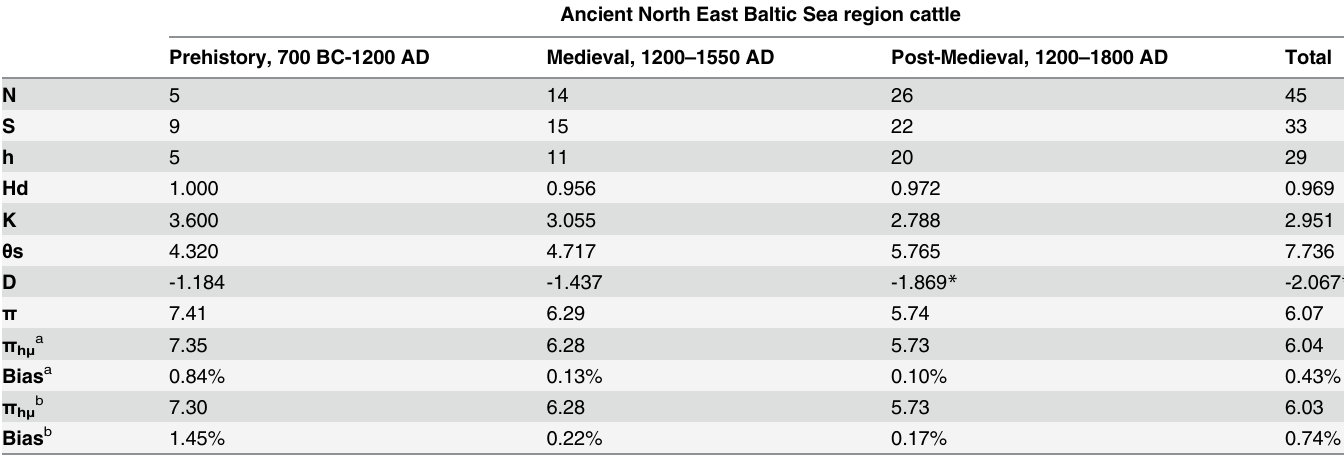
Table 1. Summary statistics of mtDNA variation in ancient North East Baltic Sea region cattle from Prehistoric, Medieval, and Post-Medieval periods.